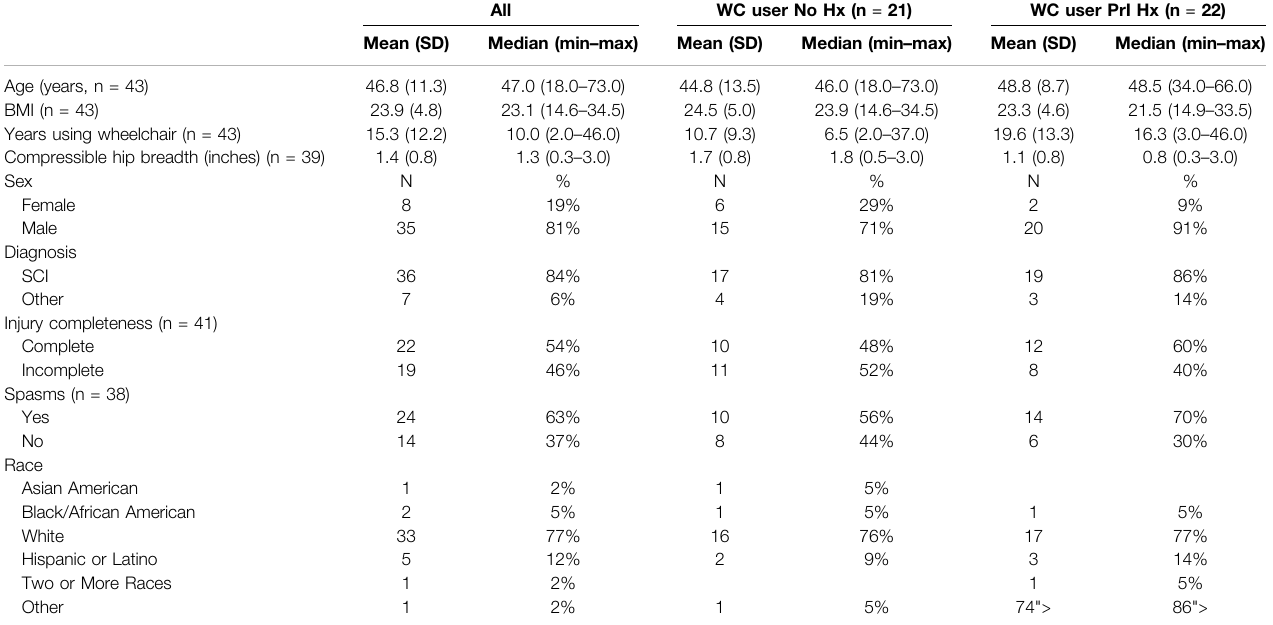
TABLE 1 | Participant